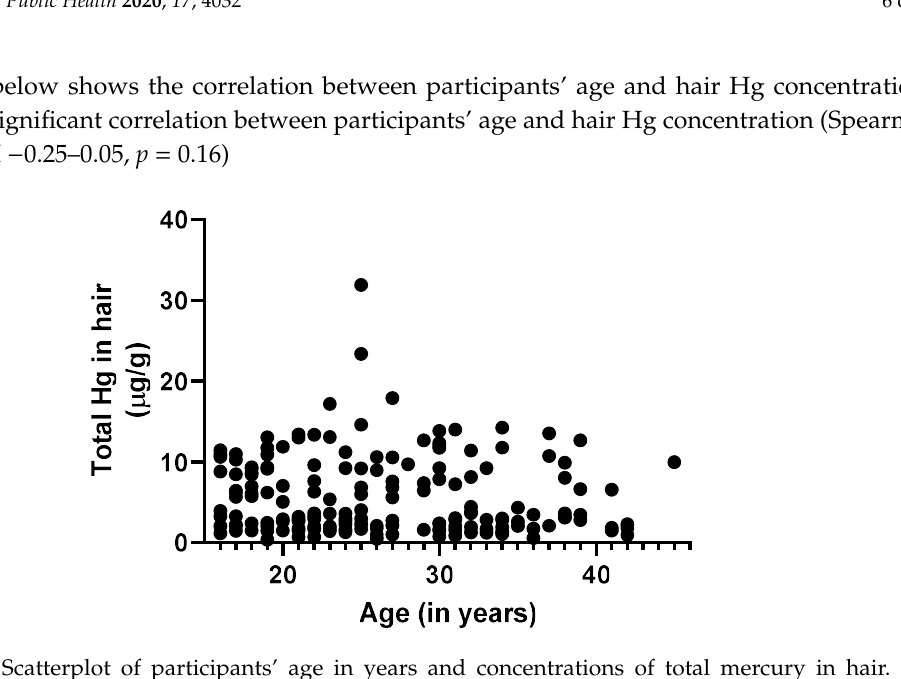
Figure 2. Total mercury concentrations in hair samples of 178 study participants.